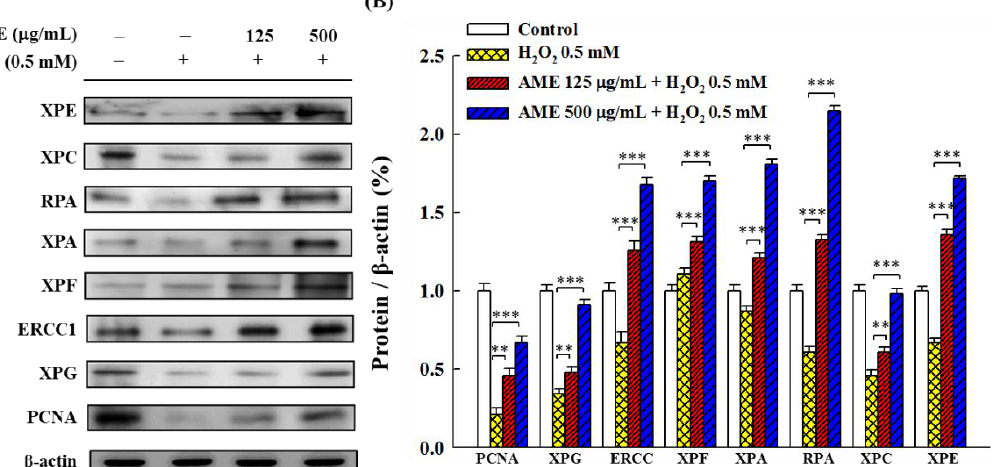
Figure 7. Effect of AME pretreatment on the expressions of NER-related proteins in H 2 O 2 -stimulated PC12 cells. ( A ) Changes in protein expression. ( B ) Densitometric quantitation. The data were estimated from triplicate independent experiments. The control group was the cells grown without treatment with extract sample and H 2 O 2 stimulation. The protein expressed by this group was set as 1.0. The significance of the difference in data compared to the vehicle group is labeled as ** p < 0.01 and *** p < 0.001.